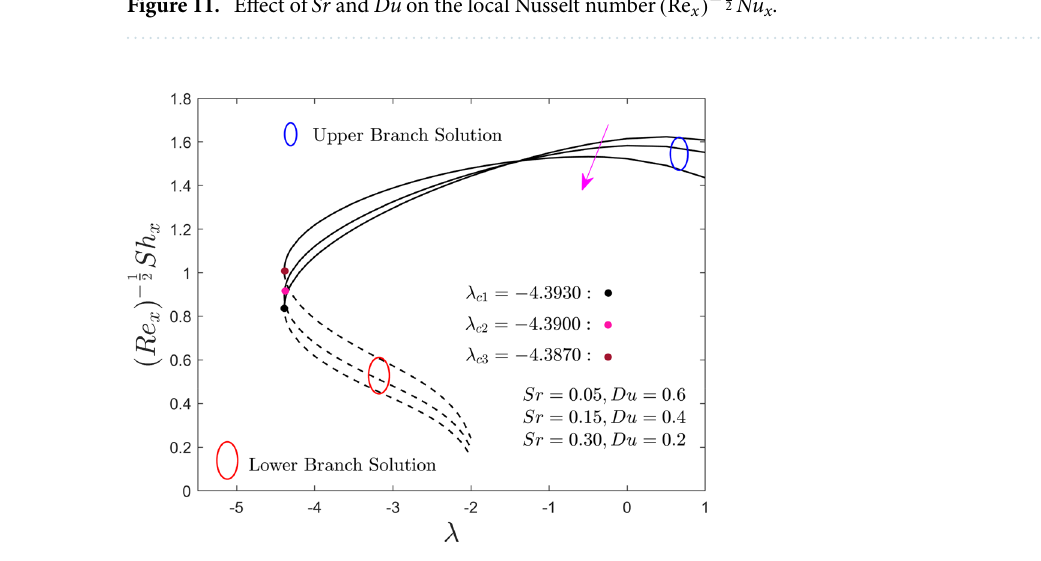
Figure 11. Effect of Sr and Du on the local Nusselt number ( Re x ) −